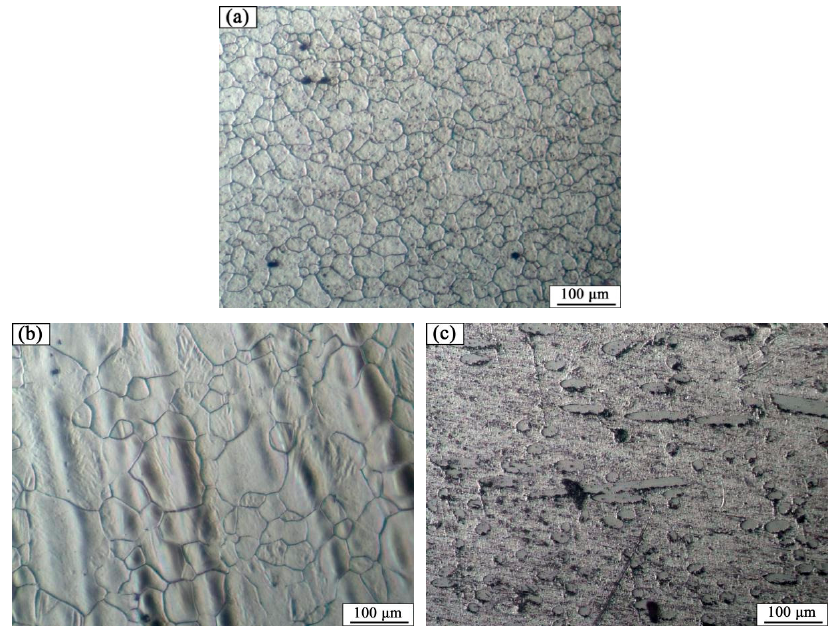
Figure 3. The microstructures of base materials ( a ) AZ31B magnesium alloy plate, ( b ) AZ31B magnesium alloy rivet, and ( c ) FRP plate.